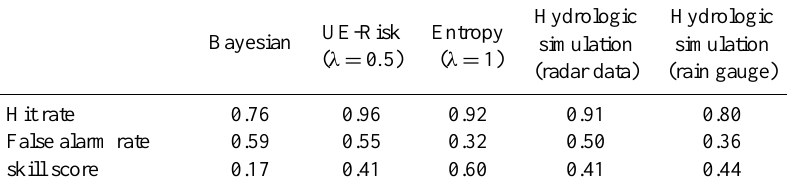
Table 6. Reliability summary analysis: values of hit rate, false alarm rate and skill score are presented in order to compare the methodologies.